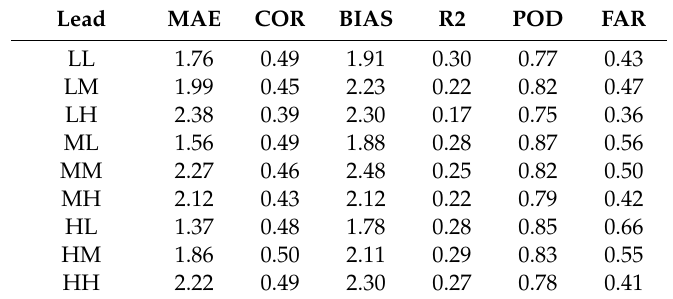
Table 5. Nowcasting skill for di ff erent temporal variability scenarios with a lead time of 1 h. Lead MAE COR BIAS